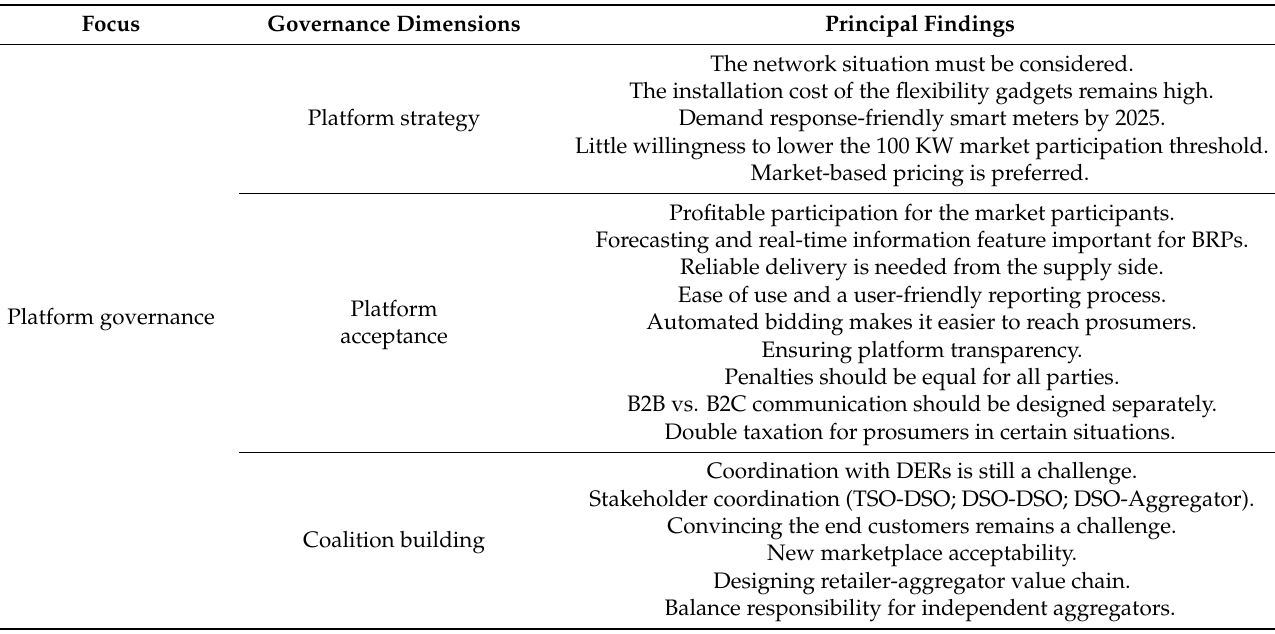
Table 4. Summary of findings on platform governance